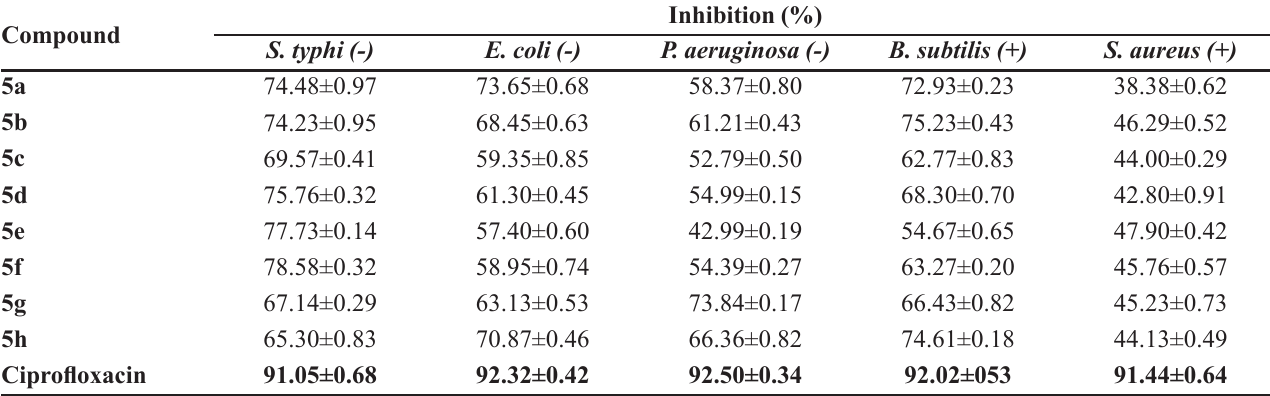
TABLE II - Antibacterial activity (% inhibition) of different 2-furyl(4-{4-[(substituted)sulfonyl]benzyl}-1-piperazinyl)methanone derivatives ( 5a-h ) Compound